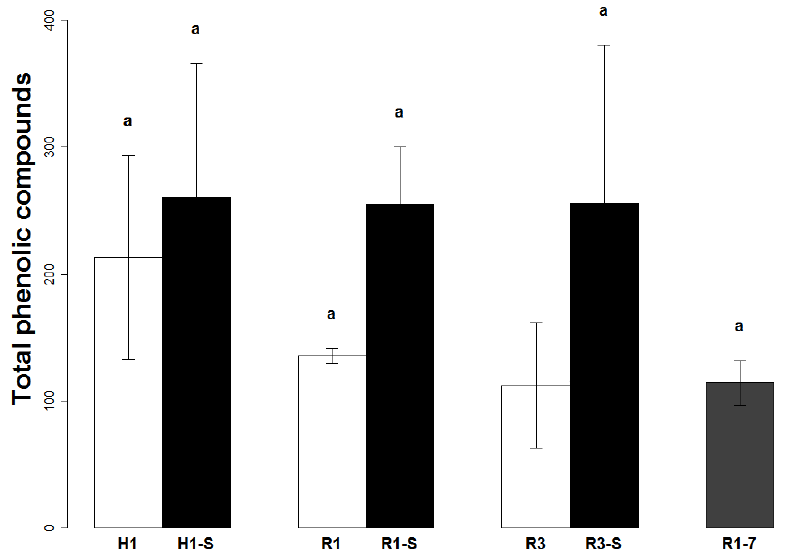
Figure 4. Total phenolic compounds contained in the pulp of cv.’Cogshall’ mango ( µ g g FM − 1 ), depending on harvesting dates (H1 and H3 stages), the treatments applied from control of non-irrigated (“S”) trees, ripening (from H1 = R1 or R1-S, from H3 = R3) and the treatments applied (highest rates of irrigation and non-irrigated (“S”) trees). The white bars indicate the control fruits, the black bars indicate the fruits from the non-irrigated orchard, and the grey bars indicate the ripe fruits after 14 days at 12 or 7 ◦ C. Identical letters represent equal mean values (no statistical difference between means at p < 0.05 according to Tukey’s multiple comparison